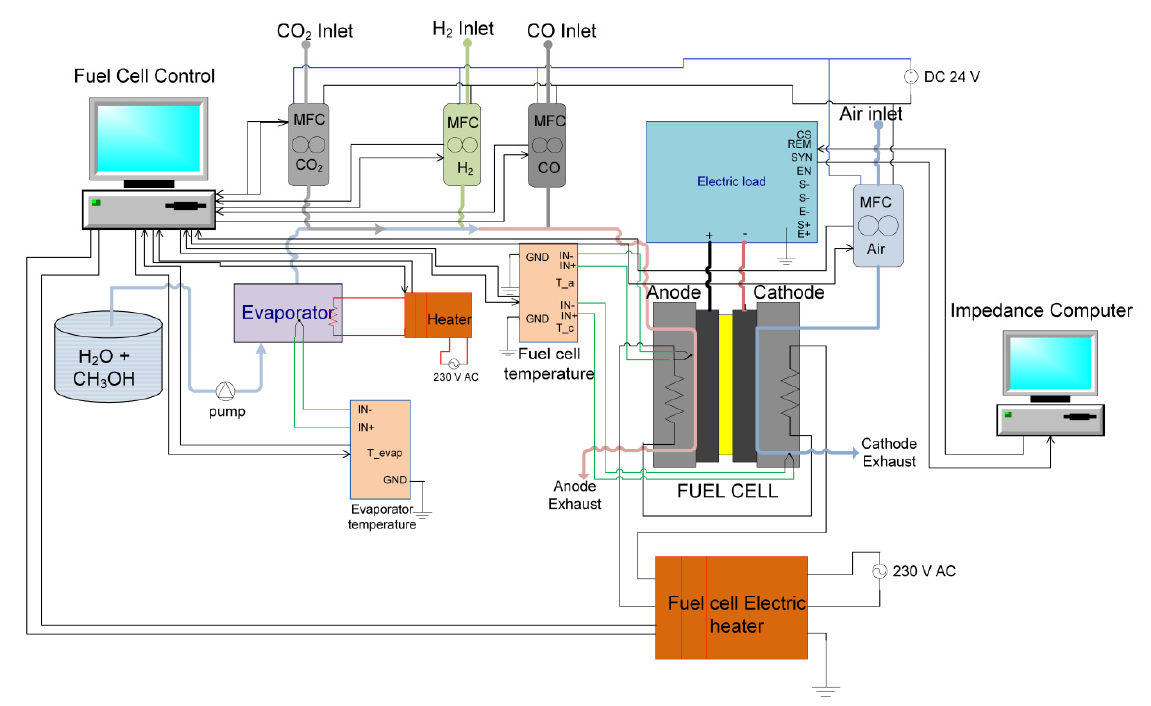
Figure 1. Experimental